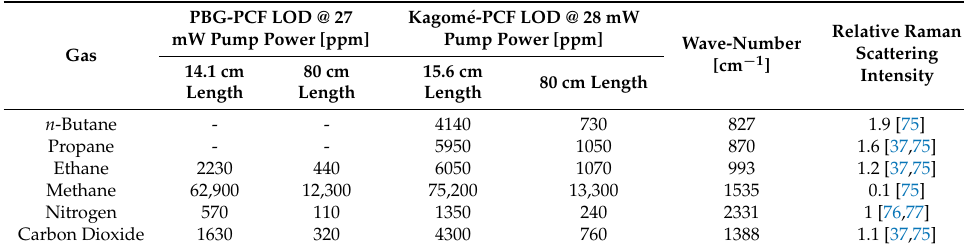
Table 5. Limit of detection in ppm for optimized fiber lengths and 80 cm long fibers and 1 s integration time at 2 bar input pressure. Higher laser power leads to a linear decrease in the LOD